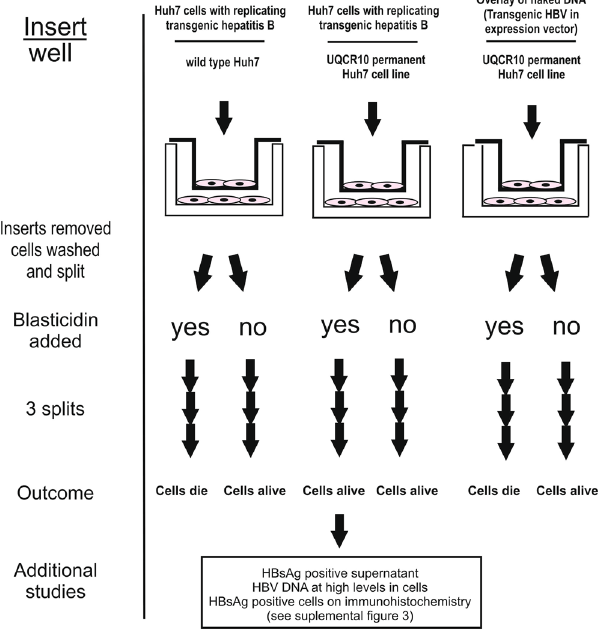
Figure 5. Transgenic confirmation studies. Experimental outline and results, which demonstrates that permanent UQCR10 Huh7 cell lines are permissive for sustained infection by transgenic